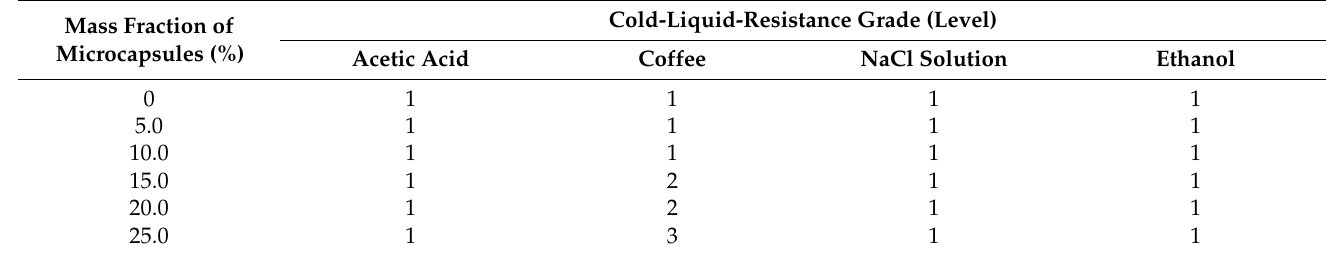
Table 13. Liquid-resistance grade of coating with different microcapsule content.